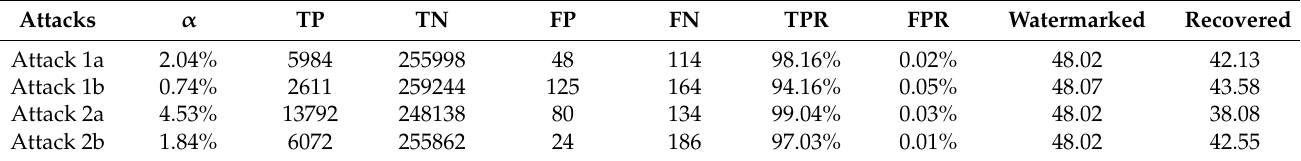
Table 5. Performance comparison of tamper detection and image quality against four types of attacks.